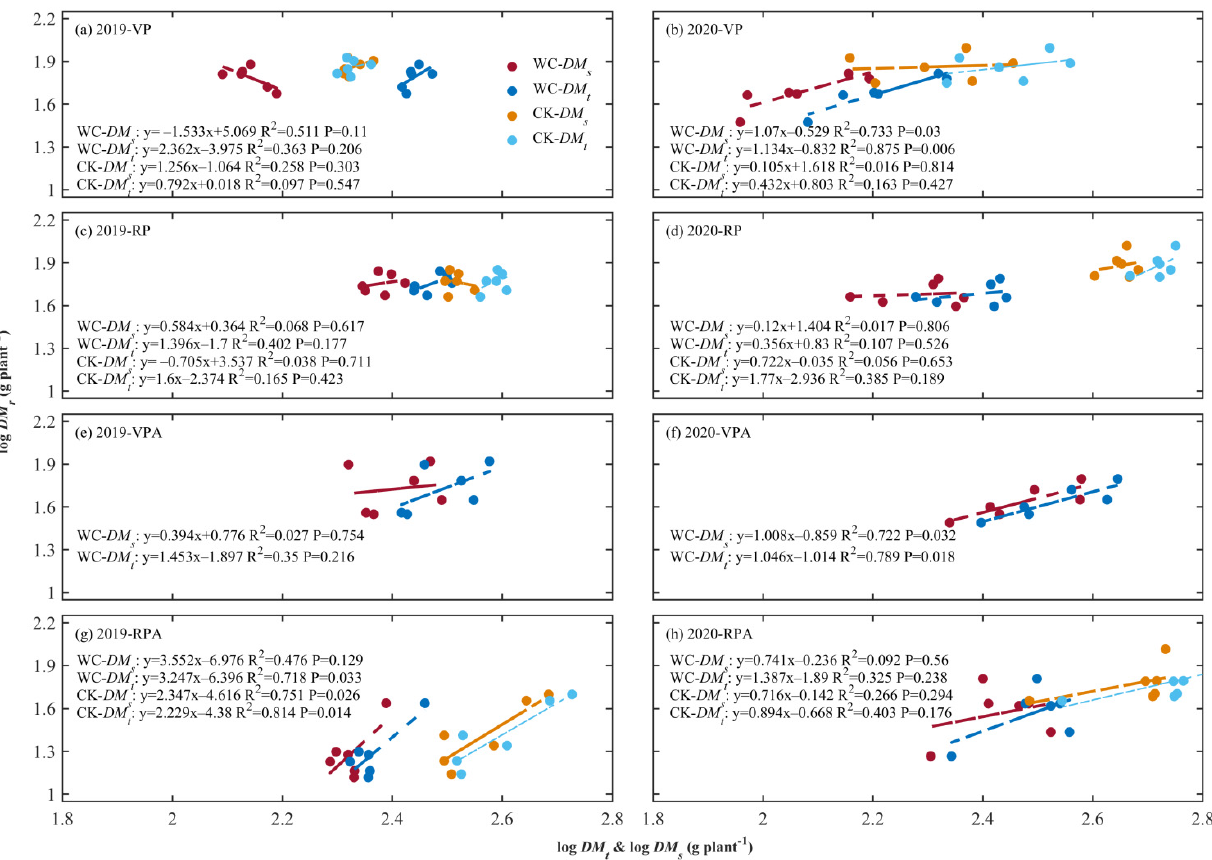
Figure 3. The ARs between root and shoot and total plant in 2019 and 2020.